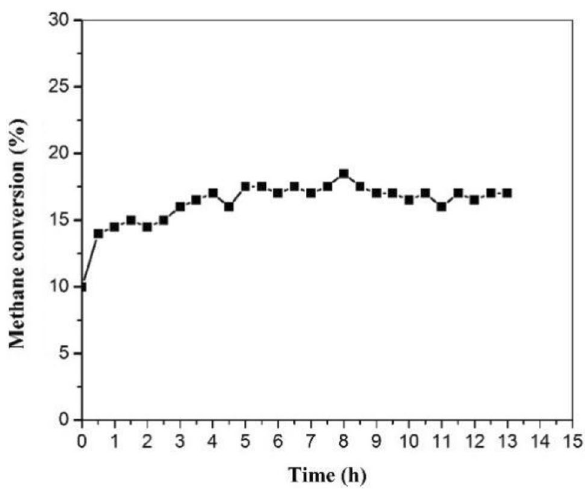
Fig. 2 Enhanced stability of Ni/SBA-15 in methane decomposition at a reaction temperature of 500 °C for 13 h on stream. Results are plot- ted on the basis of methane conversion adopted from Urdiana et al.